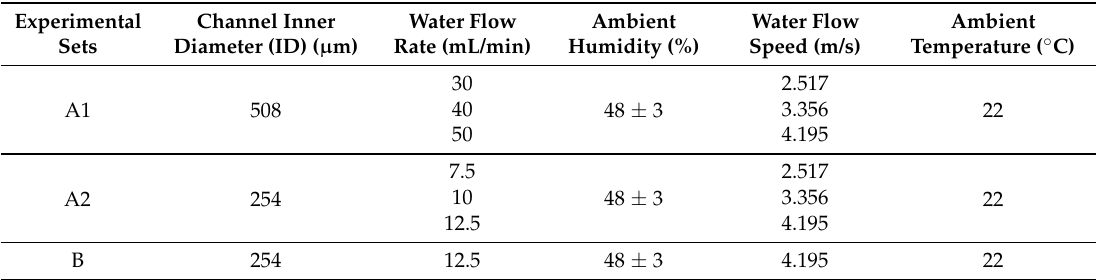
Table 1. Operating conditions of the microfluidic Kelvin water droppers